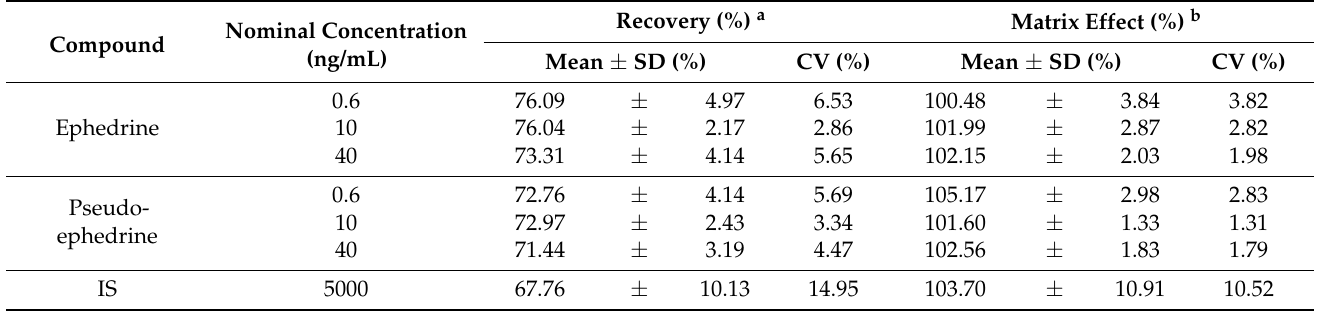
Table 2. Extraction recovery and matrix effect of ephedrine, pseudoephedrine, and